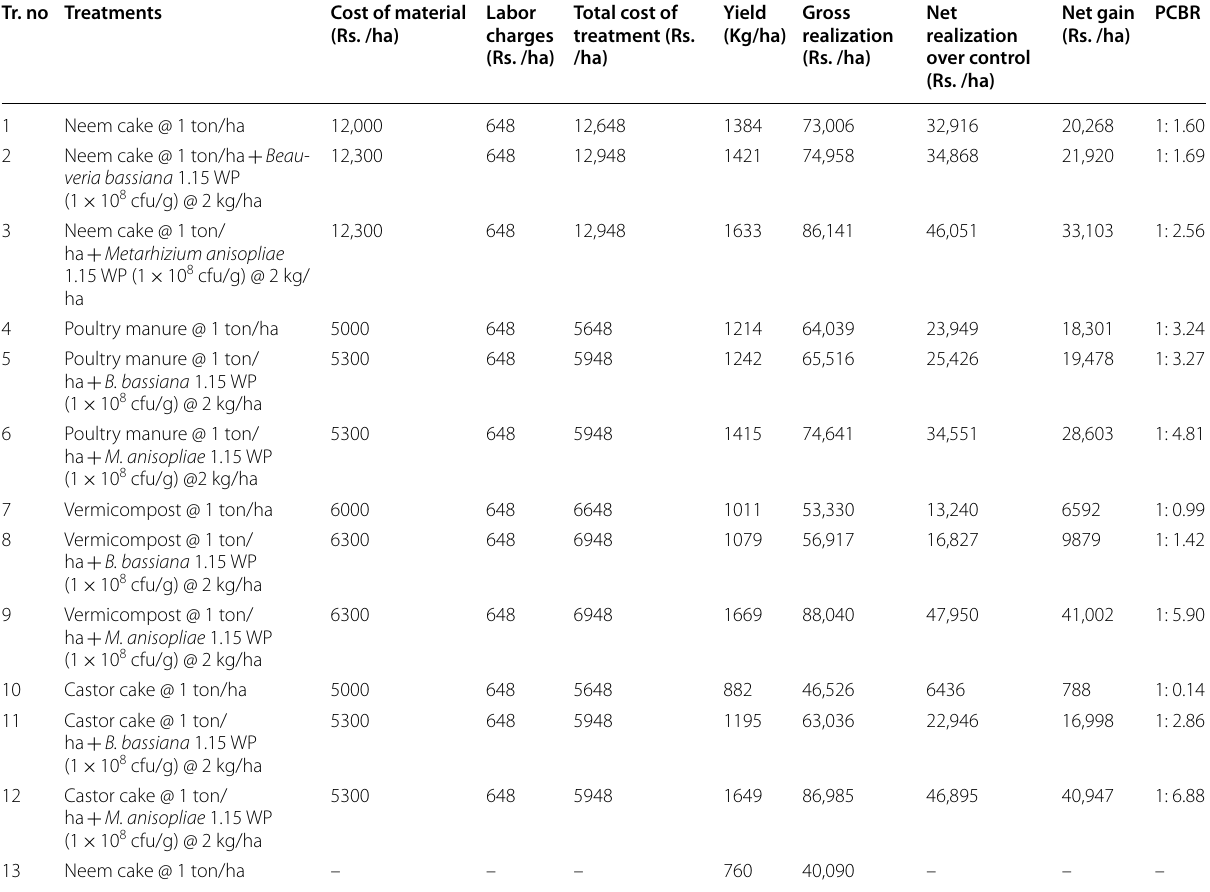
Table 9 Economics of entomopathogenic fungi enriched with organic amendments evaluated against white grub in